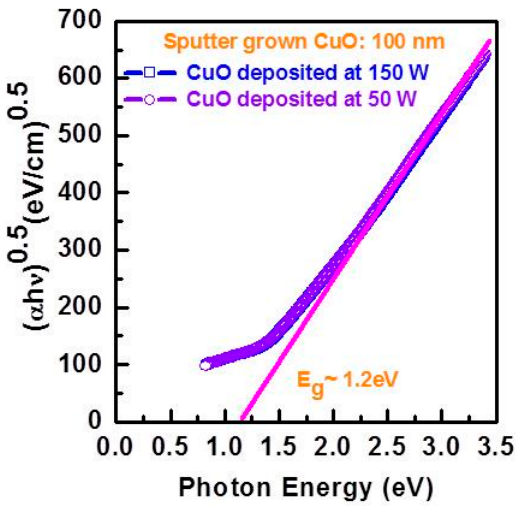
Figure 10. Tauc plot of ( α h ν ) 0.5 vs . photon energy of CuO thin film grown at sputtering power of 50 W and 150 W followed by rapid thermal treatment at 300 °C for 1 min. The extrapolated intercept gives the optical band gap of CuO.